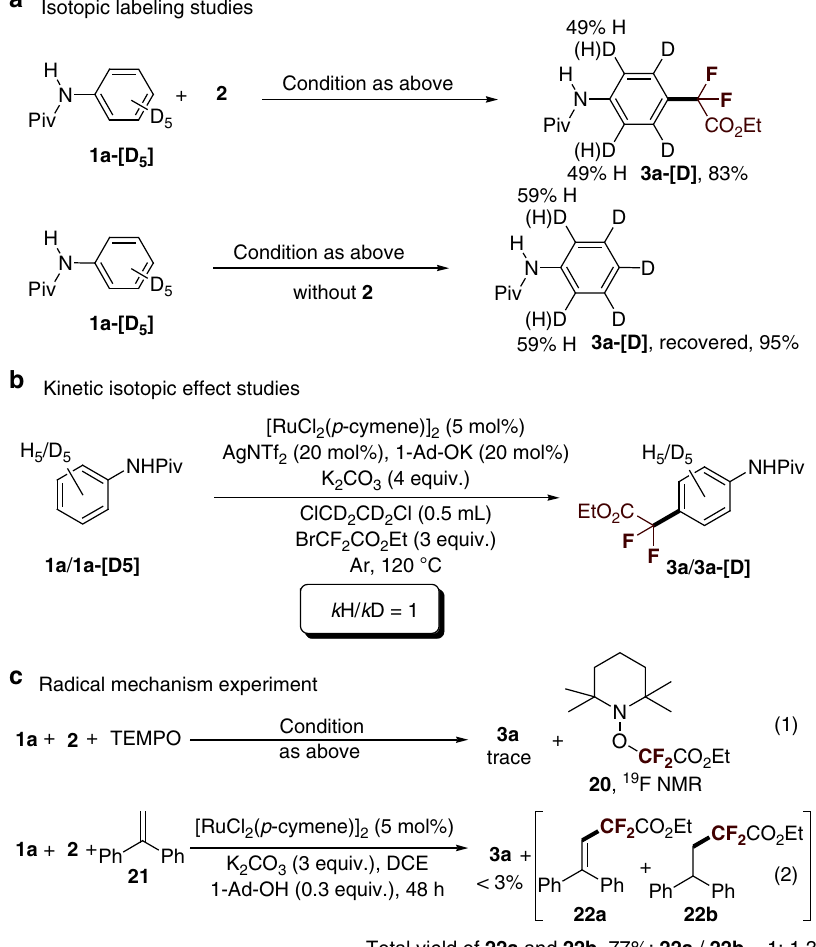
Fig. 7 Deuteration and radical experiments. a Isotopic labeling studies. b Kinetic isotopic effect studies. c Radical mechanism